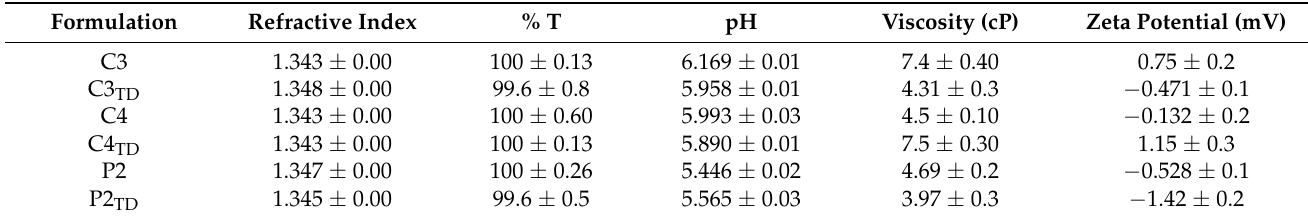
Table 3. Physicochemical properties of placebo and TD-loaded NE